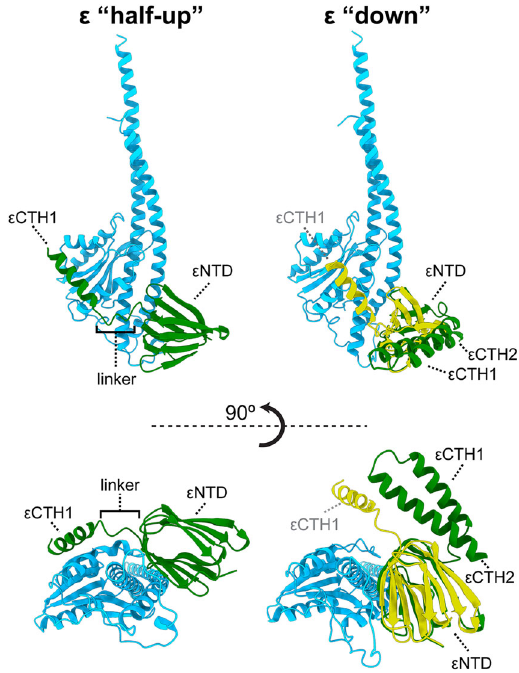
Fig. 6 Rotation of the ε NTD increases the distance to the ε CTH1 binding site. To highlight the relative rotation of the ε subunit between the half-up and down sub-states, the State 2 half-up ε subunit was superposed onto the State 2 down ε NTD (shown in yellow). After the ε NTD rotates about the γ subunit, the distance between ε CTH1 and its binding site on γ is increased in the down sub-state and is less likely to attach to the central